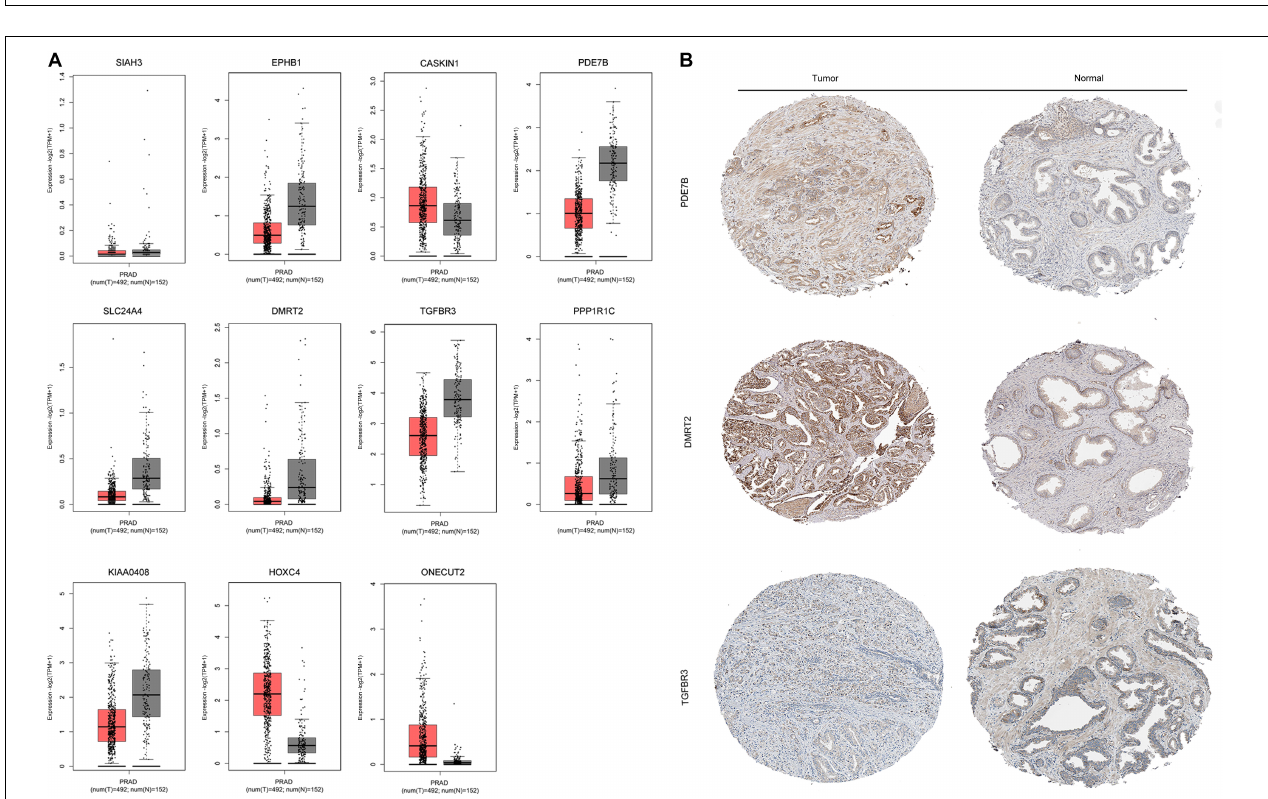
FIGURE 9 | Validation of miRNA-regulated genes by GEPIA and HPA databases. (A) Differentially expressed genes identified in the GEPIA database. (B) Differentially expressed genes identified in the HPA database.